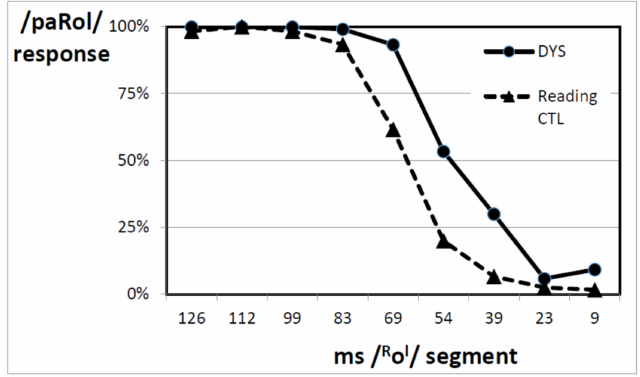
Figure 4. Identification functions of subsamples of DYS and CTL children with the same reading